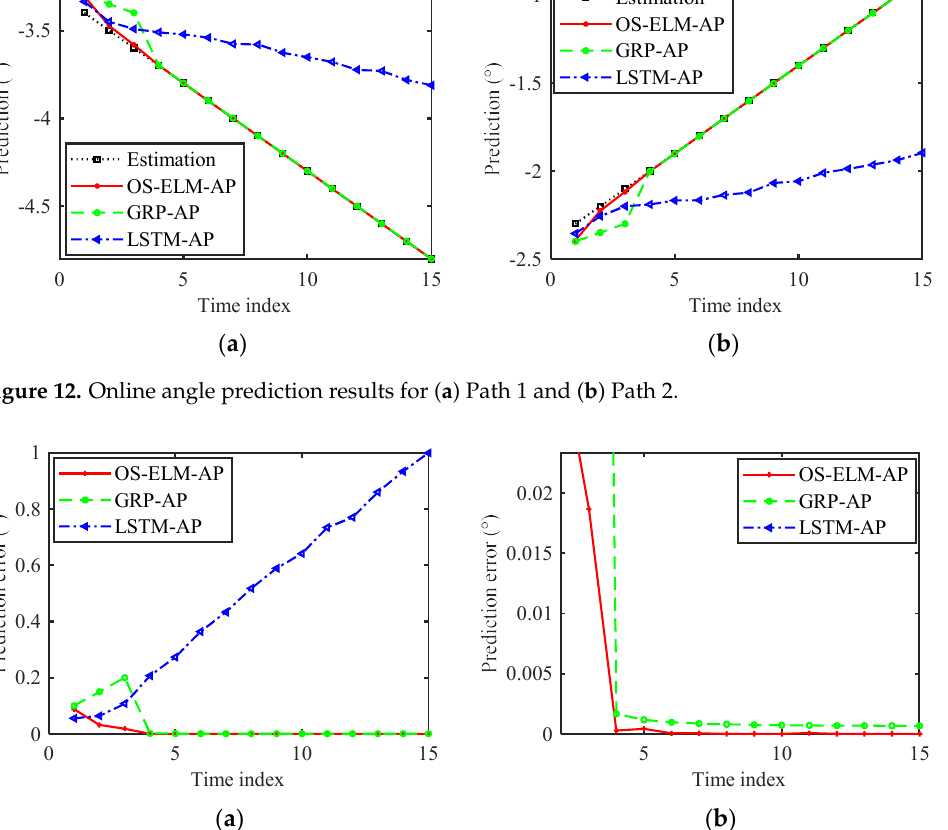
Figure 13. Online angle prediction errors for Path 1. ( a ) Prediction errors. ( b ) Magnified view of ( a ).